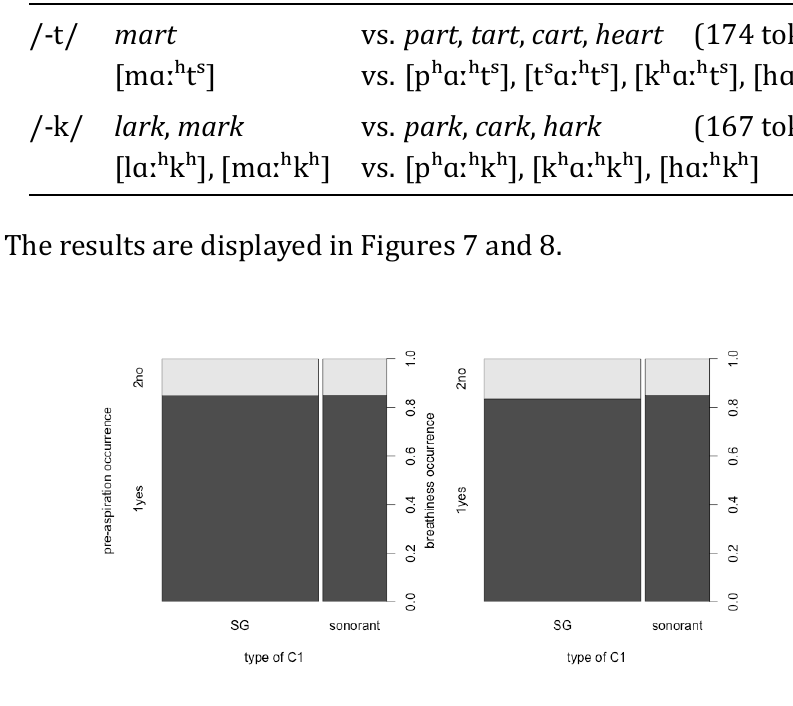
Figure 7: Frequency of occurrence, for pre-aspiration (left) and breathiness (right), de- pending on the type of C 1 ; context of long